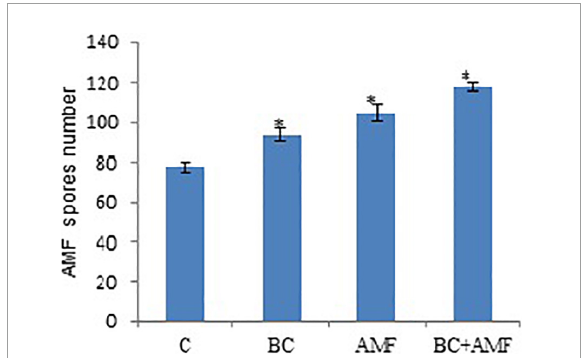
FIGURE2 The AMF spore numbers in soil affected by biochar and AMF under drought conditions. C, control; BC, biochar; AMF,